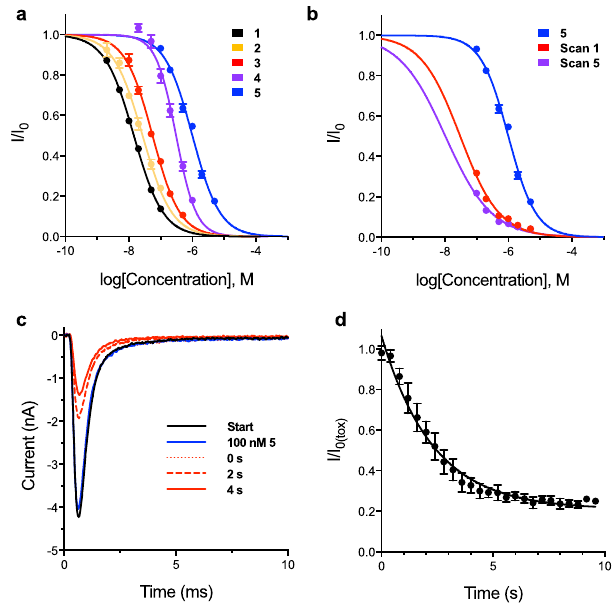
Fig. 2 Photochemical release of STX-ea 1 results in a block of Na V